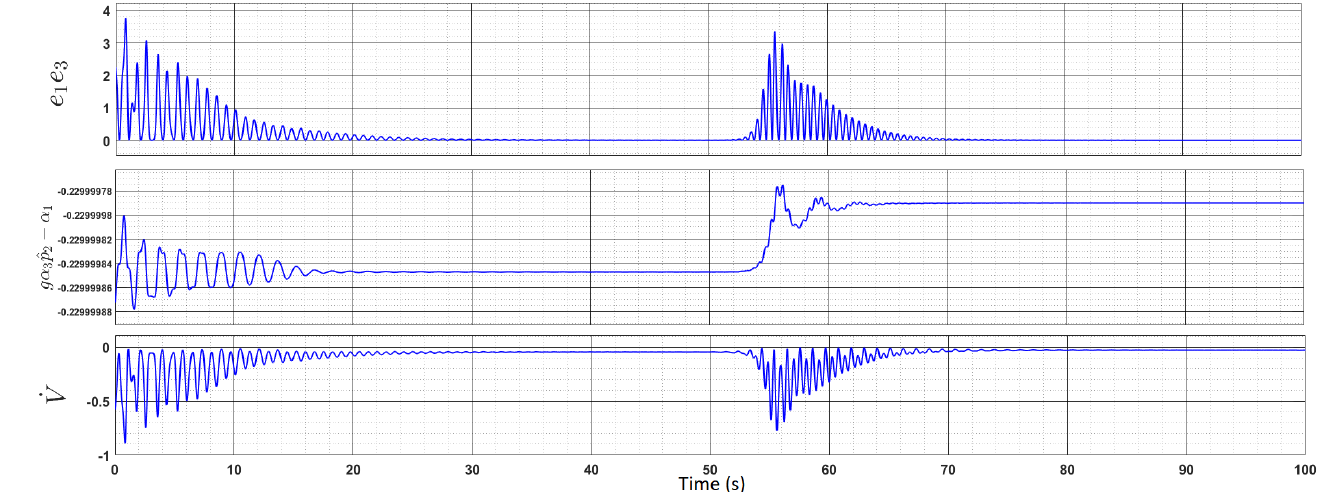
Figure 20. Validation of negative-definite derivative of Lyapunov candidate function.